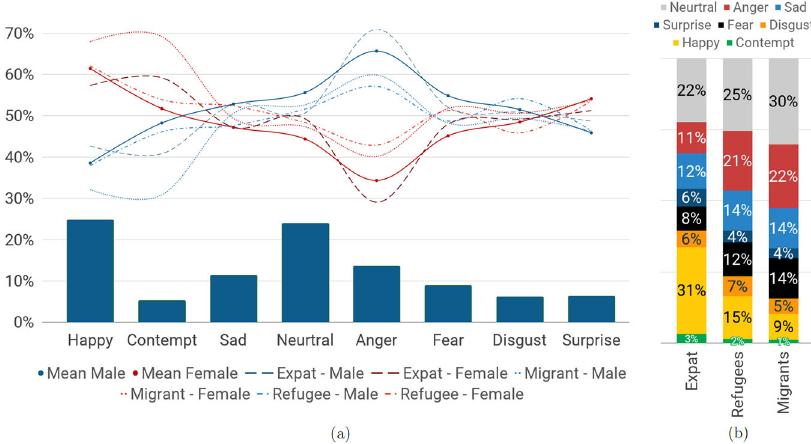
Fig. 3 The distribution of emotions across genders and groups. a On the top, a visualization of the conditional probability of gender given an emotion; on the bottom, the probability distribution of emotions over all faces in the dataset in a bar plot. b The distribution of estimated emotions per